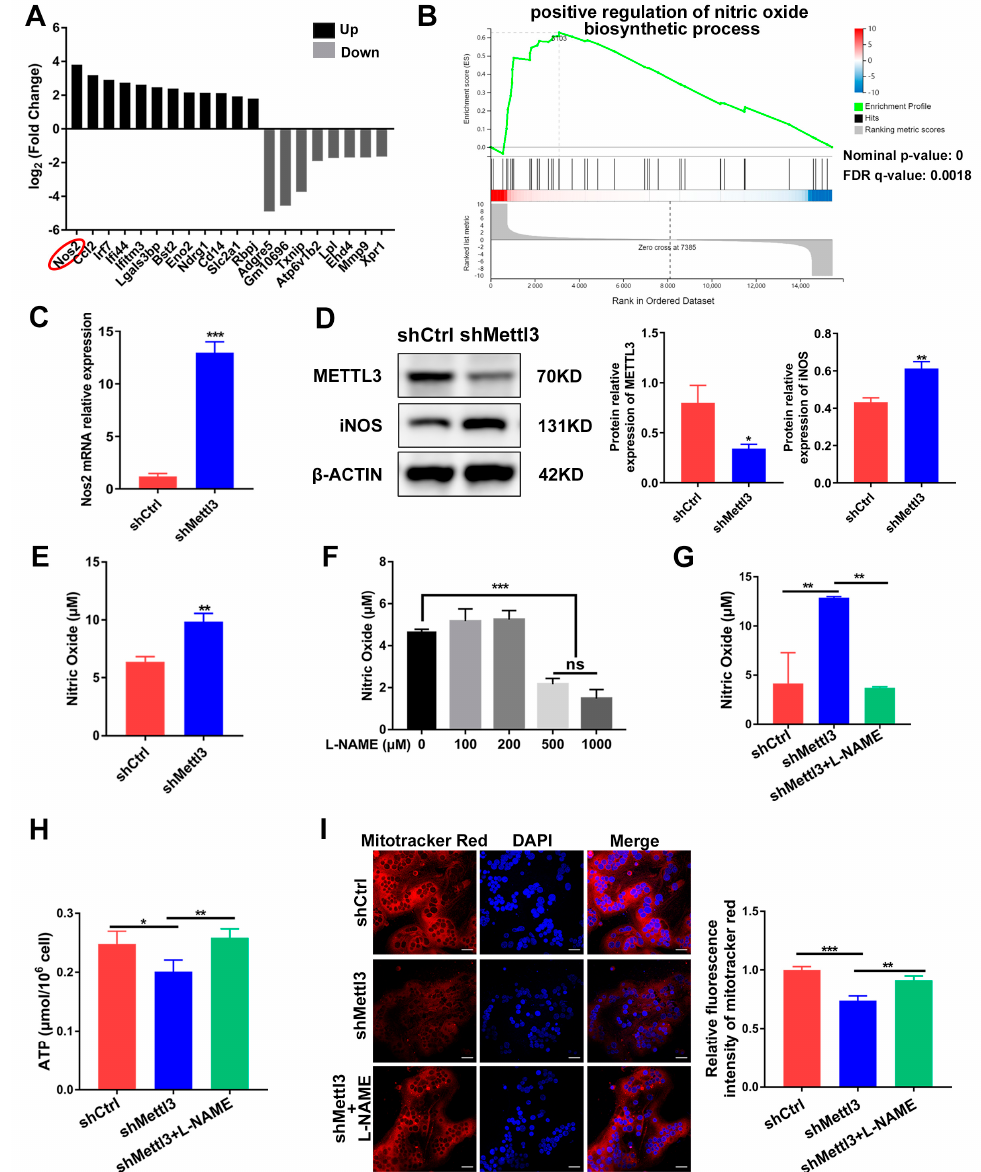
Figure 4. Identification of iNOS/NO signaling as a mediator of mitochondrial dysfunction in METTL3-deficient cells. ( A ) The top 20 differentially expressed genes from RNA sequencing data between the shMettl3 group and the shCtrl group. ( B ) The GSEA enrichment plot of the gene sets associated with positive regulation of nitric oxide biosynthetic process. ( C ) Nos2 mRNA expression was assessed using qRT-PCR. ( D ) iNOS protein level was determined with Western blotting. β -Actin was used as an internal control. ( E ) The Griess assay was performed to detect the production of nitric oxide. ( F ) RAW264.7 cells were treated with LPS (200 ng/mL) and different concentrations of L-NAME (0–1000 μ M) for 2 days, and the NO content was assessed through the Griess assay. ( G – I ) RANKL-pretreated osteoclast precursors transfected with the indicated shRNA were treated with LPS (200 ng/mL) in the absence or presence of L-NAME (500 μ M) for 2 days. ( G ) The NO content was analyzed using the Griess assay. ( H ) ATP concentration was measured using an ATP assay kit. ( I ) Confocal images of cells stained with Mito-Tracker Red CMXRos and DAPI. Scale bars, 25 μ m. The relative fluorescence intensity of Mito-Tracker Red was analyzed using the ImageJ software. The data are shown as the mean ± SD ( n = 3). ns, no significance; * p < 0.05; ** p < 0.01; *** p < 0.001.